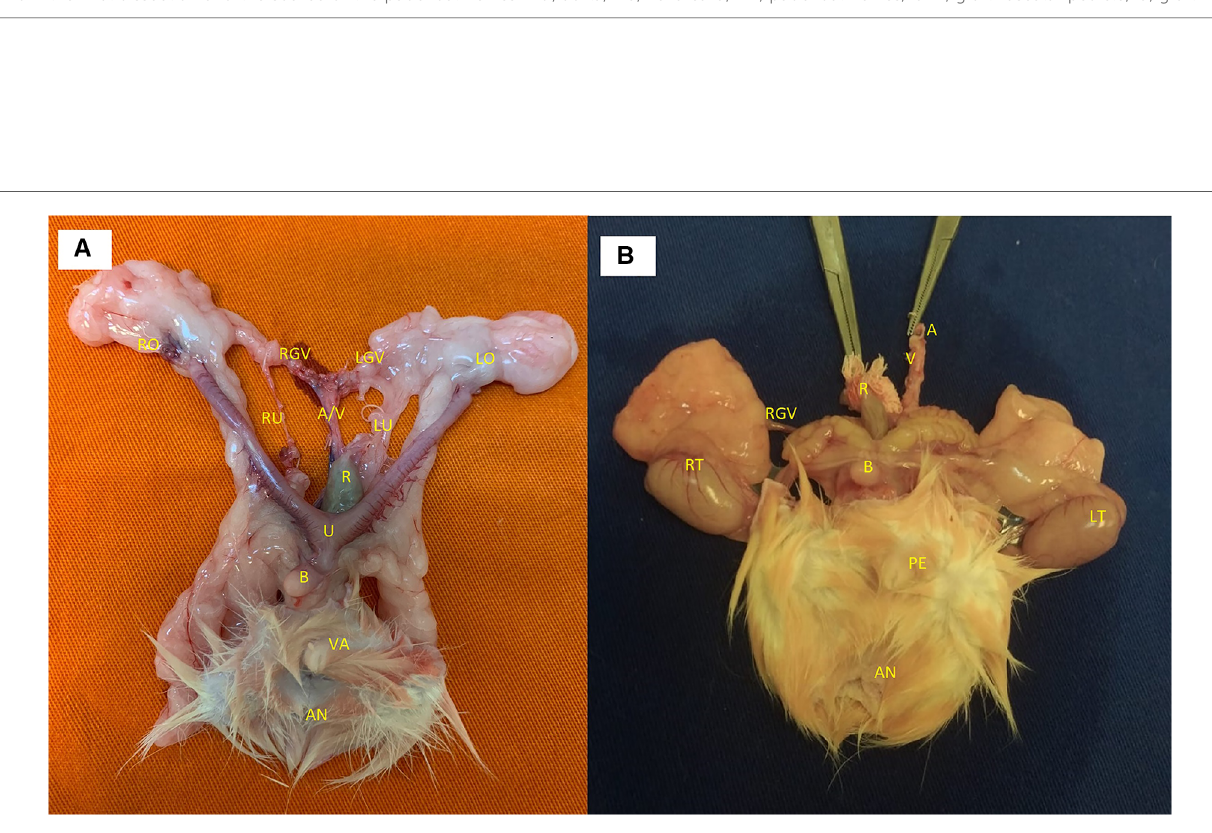
FIGURE 2 ( A ) Vascular dissection details: AO, aorta; VC, vena cava; IIV, internal iliac vessels; EIV, external iliac vessels; CIV, common iliac vessels. ( B ) Pedicle vessels from the fi nal dissection and the source of the pudendal nerves: AO, aorta; VC, vena cava; NP, pudendal nerves; GVP, graft vascular pedicle; G, graft.